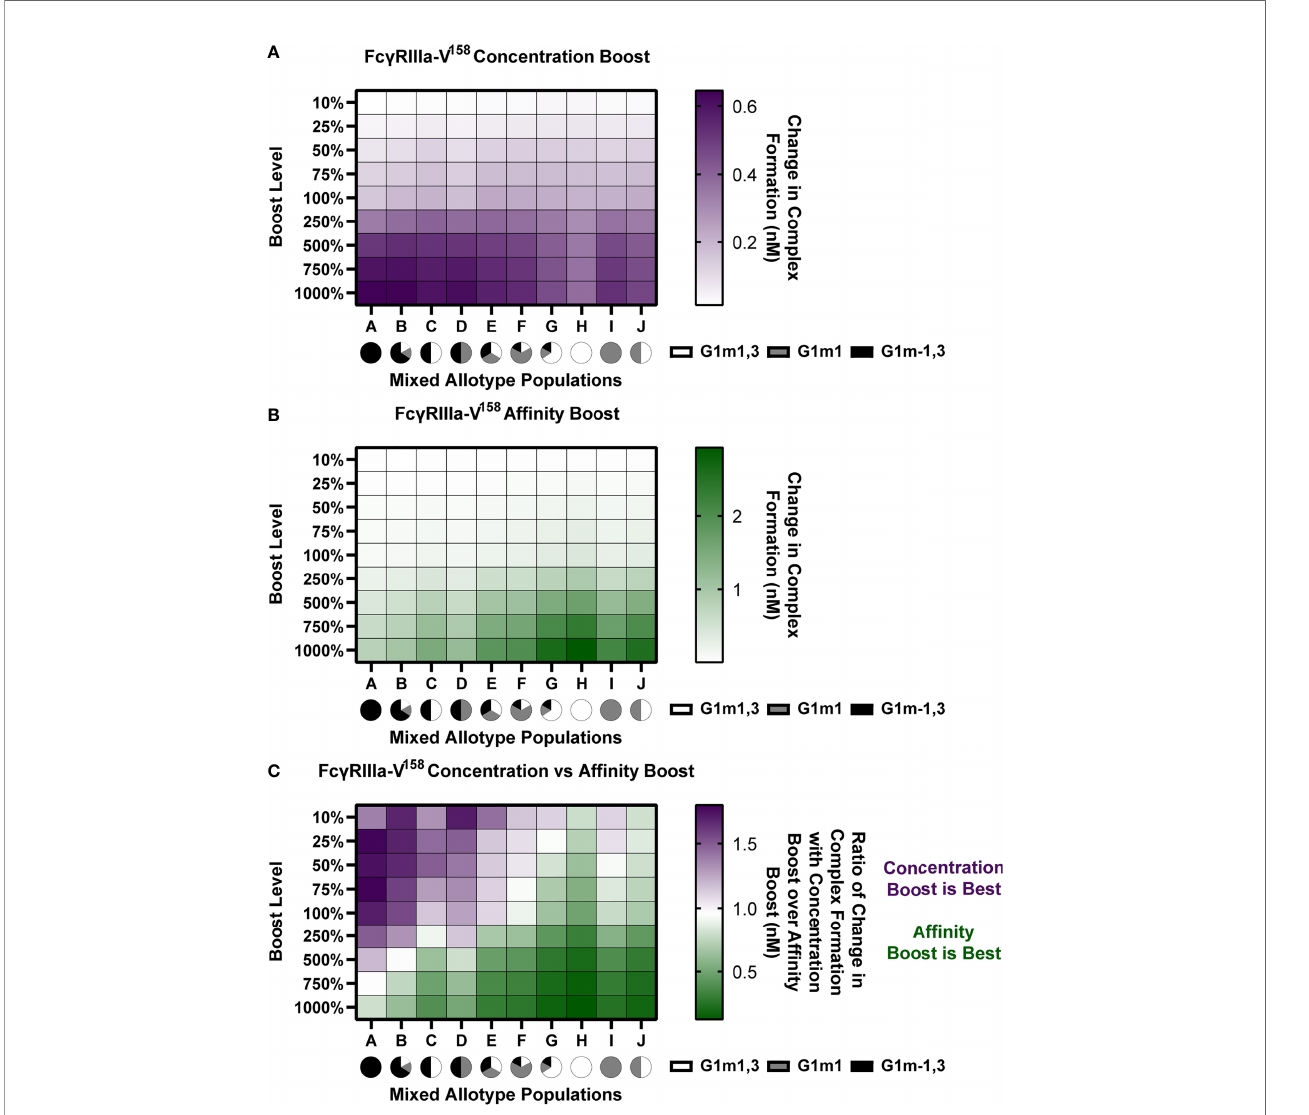
FIGURE 6 | In mixed allotype populations, the bene fi t of boosting IgG1 concentration vs. IgG1 af fi nity is dependent on the presence of the G1m-1,3 allotype. (A) Boosting of initial IgG1 concentration in mixed allotype populations (G1m1,3, white; G1m1, gray; G1m-1,3 black) for Fc g RIIIa-V 158 . Color indicates predicted change in complex formation (B) Boosting of k on IgG1- Fc g R in mixed allotype populations (G1m1,3, white; G1m1, gray; G1m-1,3 black). Color indicates predicted change in complex formation (C) The ratio of median change in complex formation with a boost in IgG1 over median change in complex formation with a boost in k on IgG1-Fc g R at each boosting level. This ratio indicates which type of boost is predicted to be most effective for increasing complex formation (IgG1 concentration, purple; k on IgG1-Fc g R,